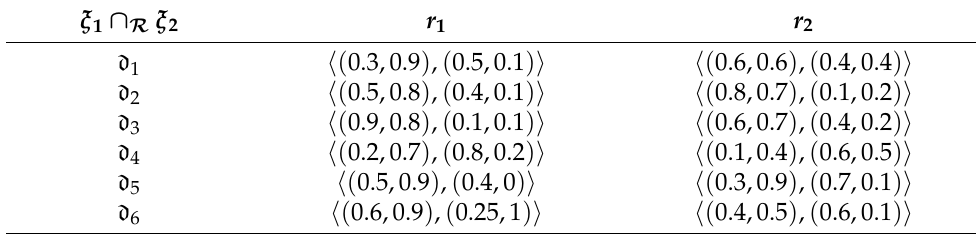
Table 13. Table for the restricted intersection ξ 1 ∩ R ξ 2 . ξ 1 ∩ R ξ